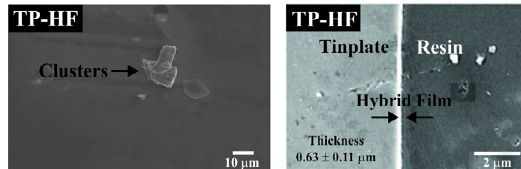
Figure 4. Micrographs obtained by SEM (top and cross section) for the hybrid film obtained.